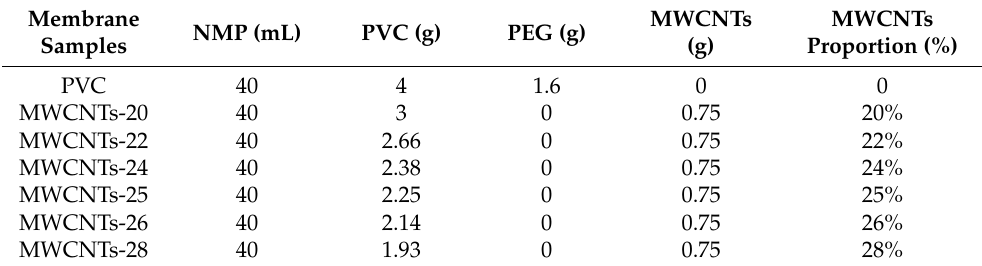
Table 1. The ingredient of membrane casting